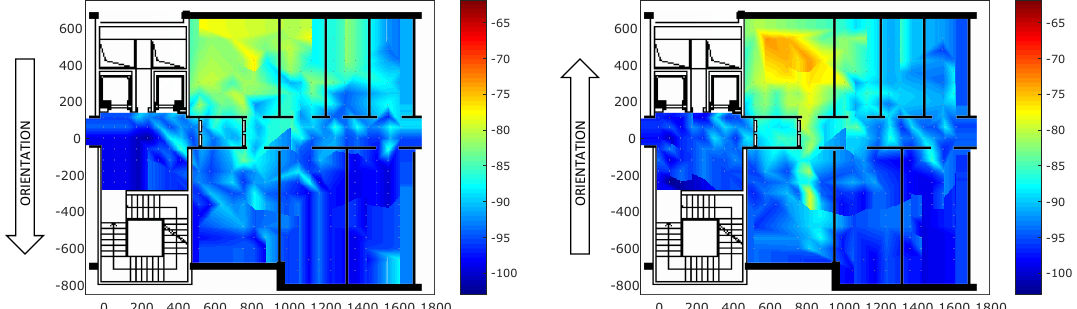
Figure 6. RSSI between Mobile 1 and Anchor 1069 at 3 dBm when the human orientation changes. On the left, the orientation corresponding to Position 2 in the dataset. On the right, the orientation corresponding to Position 4 in the